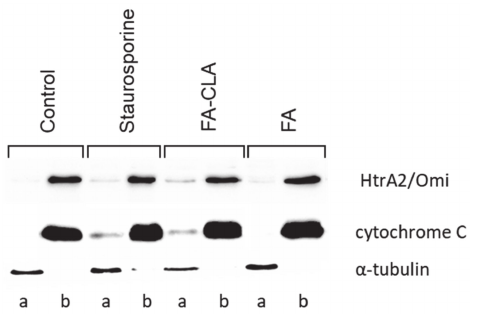
Figure 6. Expression of apoptotic proteins in different cell fractions, in the WM793 cancer cells, under the influence of a mixture of fatty acids extracted from yolk enriched and not enriched in CLA. a—cytosolic fraction, b—membrane